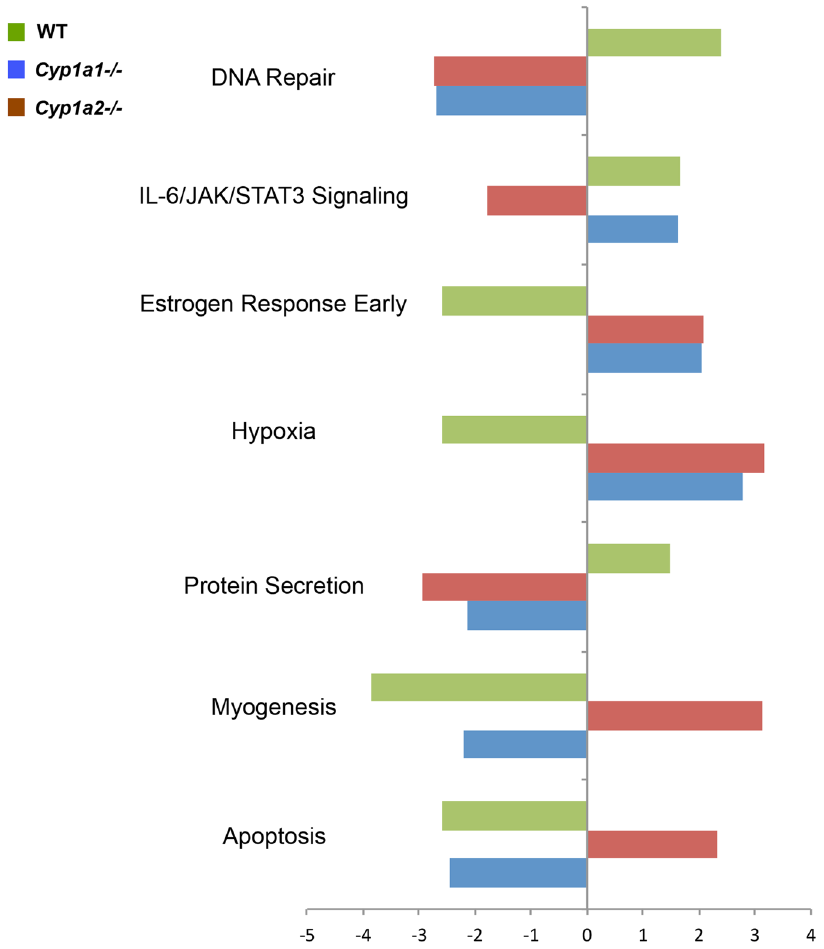
Figure 2. Gene Set Enrichment Analysis (GSEA) reveals distinct modulation of pathways between WT, Cyp1a1 − / − , and Cyp1a2 − / − , and WT mice exposed to hyperoxia. Biological processes enriched in the transcriptome footprint of hyperoxia response of three (WT, Cyp1a1 − / − and Cyp1a2 − / − ) genotypes were identified using Gene Set Enrichment Analysis (GSEA). The Normalized Enrichment Score (NES) is reported for select enriched pathways (fdr-adjusted Q-value < 0.25). An extensive search was carried out for pathways that were enriched after hyperoxia exposure (Q < 0.25) but in driven in opposite direction in WT mice compared to either Cyp1a1 − / − or Cyp1a2 − / − mice (NES are significant but have opposite signs for the hyperoxia response in either Cyp1a1 − / − or Cyp1a2 − / − compared to the response in WT mice). Key differences were observed in DNA repair and protein secretion (upregulated in WT, downregulated in knock- out) and early estrogen response and hypoxia (downregulated in WT and upregulated in knock-out